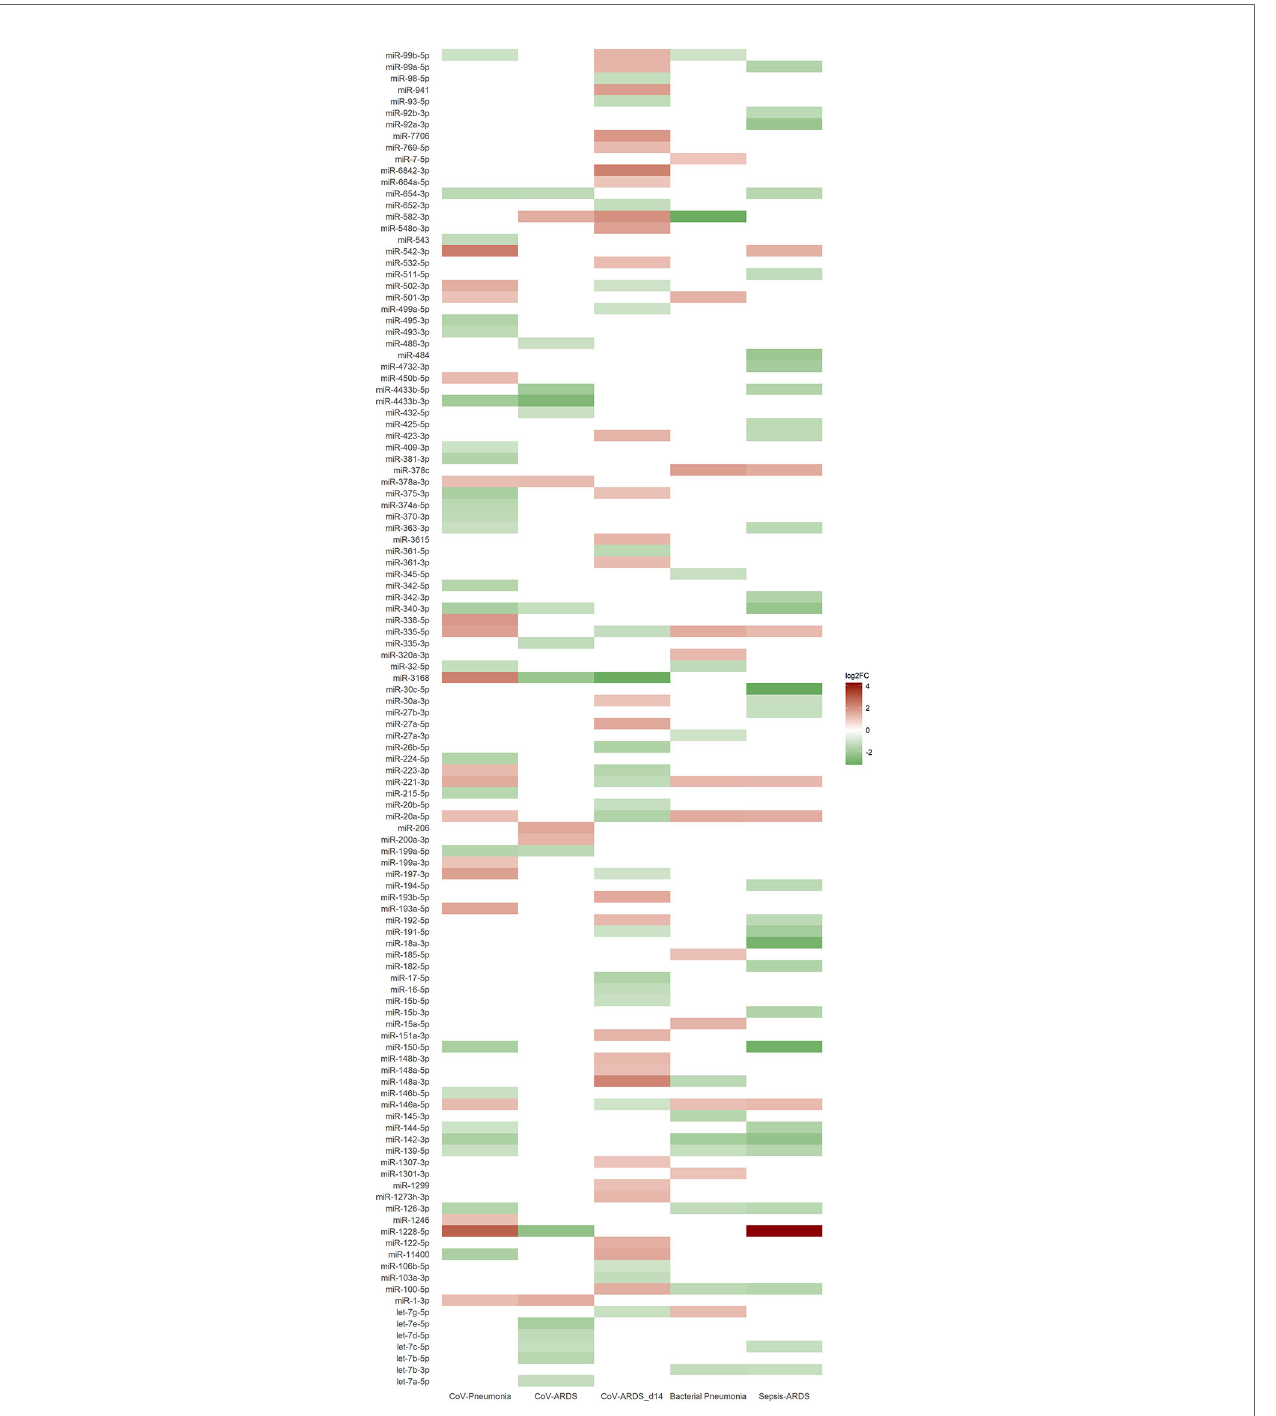
FIGURE 4 | Heat map of differentially expressed miRNAs from small RNA sequencing based on the log2FC-value of the corresponding group comparison. Blank spaces indicate no signi fi cantly different expression between the groups of the respective comparison. Green values indicate a downregulation and red values an upregulation of miRNAs. Comparisons of the different patient groups: CoV-Pneumonia = healthy controls (baseline) compared to patients with COVID-19 pneumonia; CoV-ARDS = patients with COVID-19 pneumonia (baseline) compared to patients with COVID-19 ARDS; CoV-ARDS_d14 = patients with COVID-19 ARDS at admission to the ICU (baseline) compared to day 14 of ICU treatment; Bacterial Pneumonia = patients with bacterial community acquired pneumonia (baseline) compared to patients with COVID-19 pneumonia; Sepsis-ARDS = patients with sepsis on the day of ICU-admission (baseline) compared to patients with COVID-19